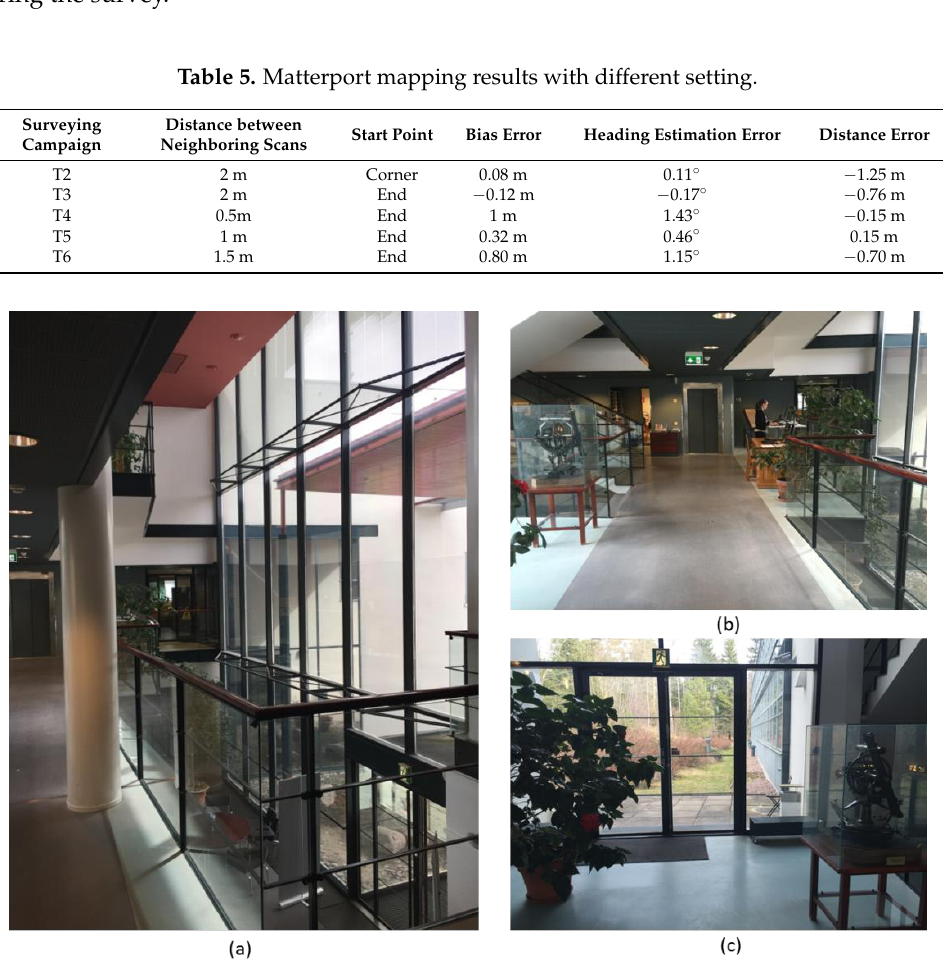
Figure 9. ( a ) The glass wall at the south of the corner, ( b ) the corridor of the second floor with various glass made infrastructure ( c ) the entrance at the north of the corner.